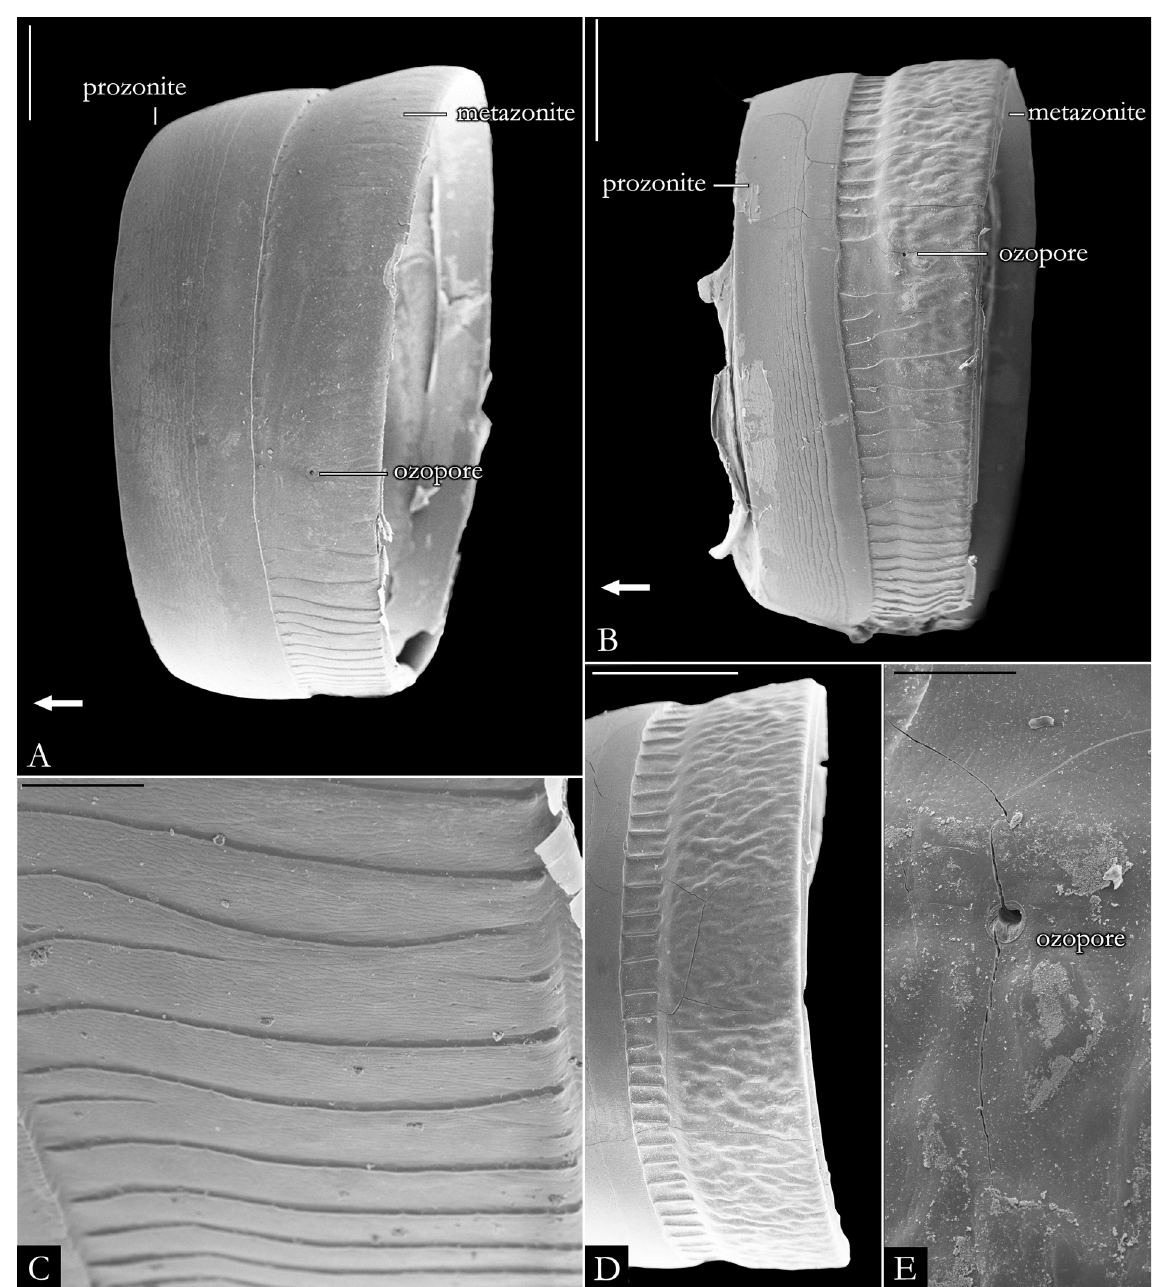
Fig. 26. SEM images of midbody rings. A . Pseudonannolene robsoni Iniesta & Ferreira, 2014 (IBSP 3506). B . P. granulata sp. nov. (MNRJ). C . Detail of the transverse striae of P. robsoni (IBSP 3506). D . Midbody ring in dorsal view of P. granulata sp. nov. (MNRJ). E . Ozospore of P. granulata sp. nov. (MNRJ). Scale bars: A–B, D = 1 mm; C = 0.1 mm; E = 0.02